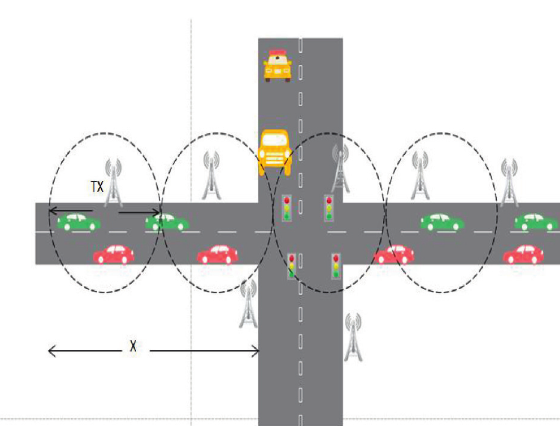
Figure 5: Road segmentation for RSUs deployment.